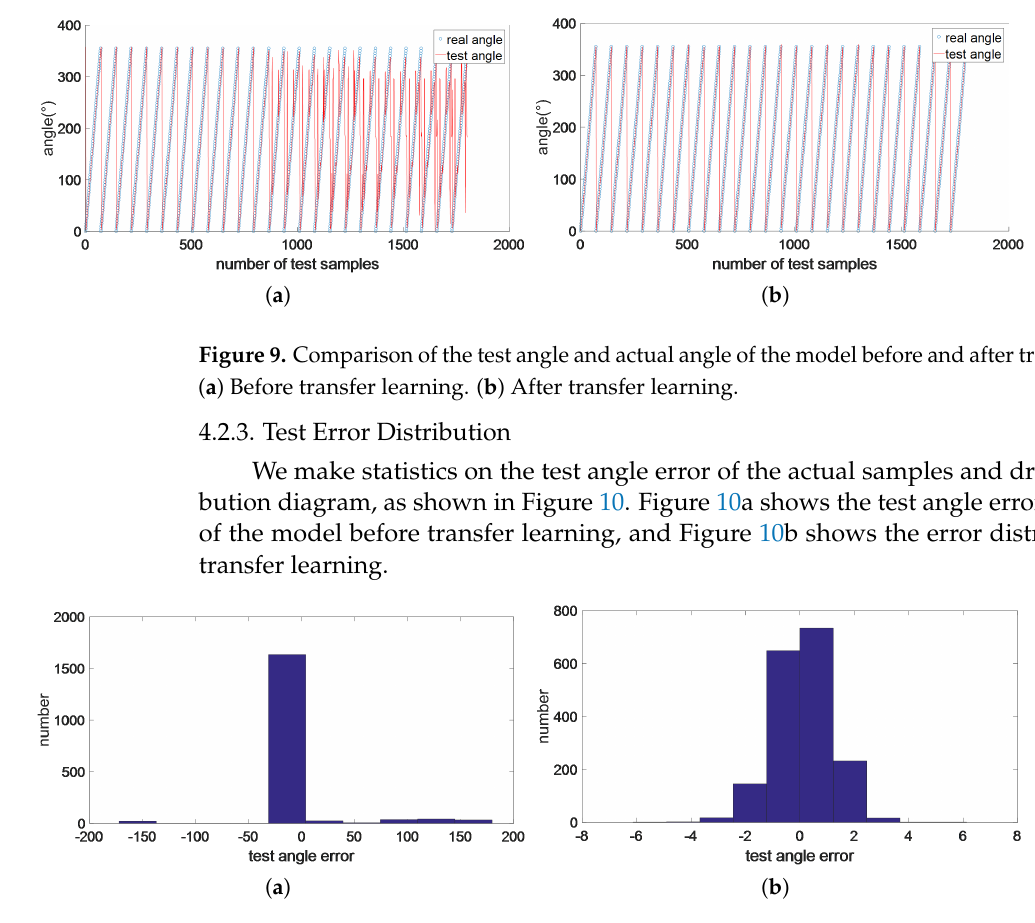
Figure 10. The test angle error distribution before and after the transfer learning. ( a ) Before transfer learning. ( b ) After transfer